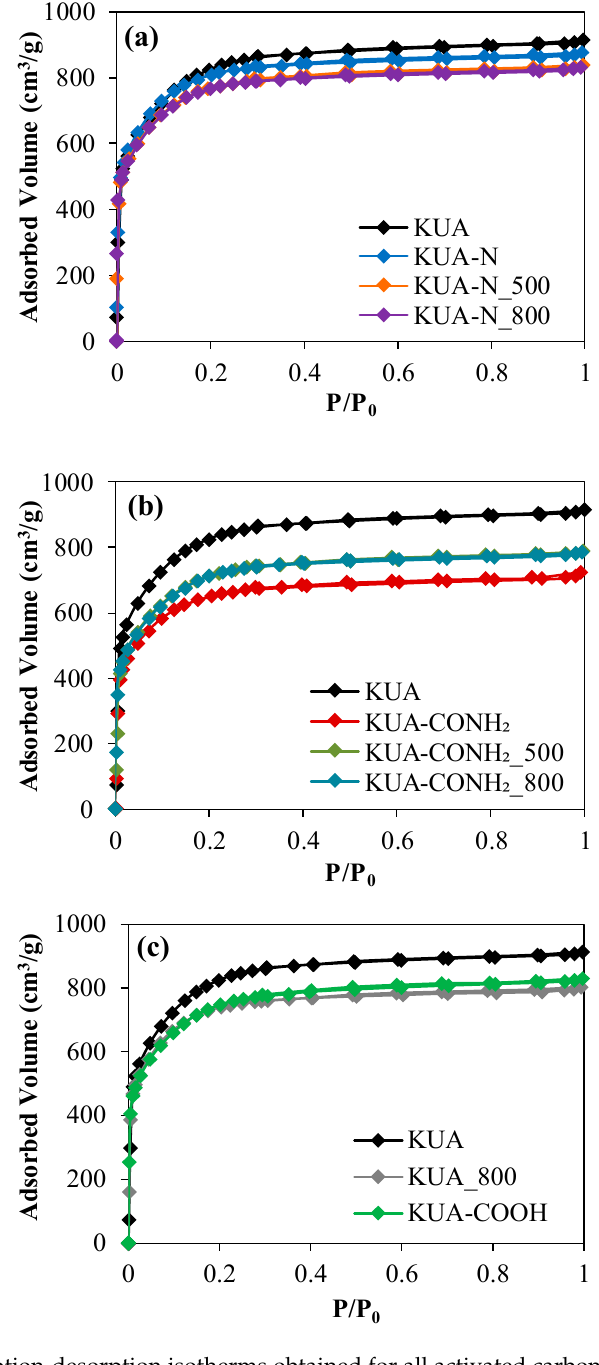
Figure 1. N 2 adsorption-desorption isotherms obtained for all activated carbons: ( a ) KUA, KUA-N and related heat-treated samples, ( b ) KUA, KUA-CONH 2 and related heat-treated samples, ( c ) KUA and related heat-treated sample. Table 1. Porous texture of the activated carbons.